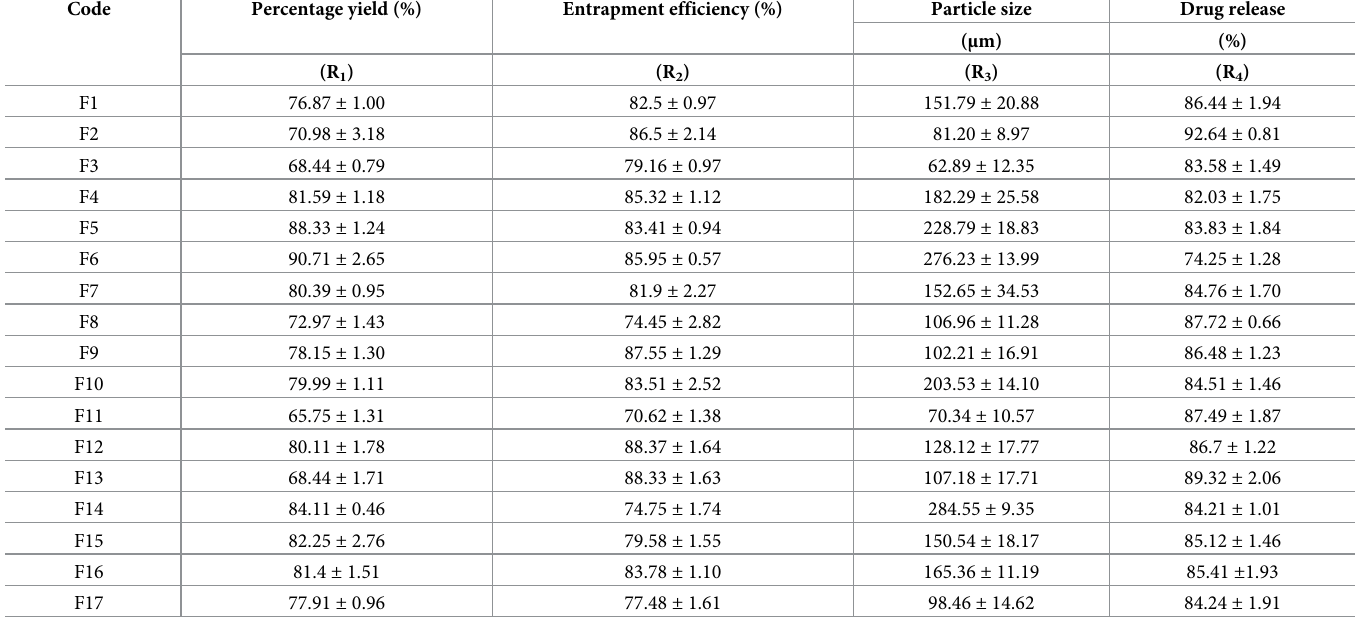
Table 2. Observed values of independent variables in